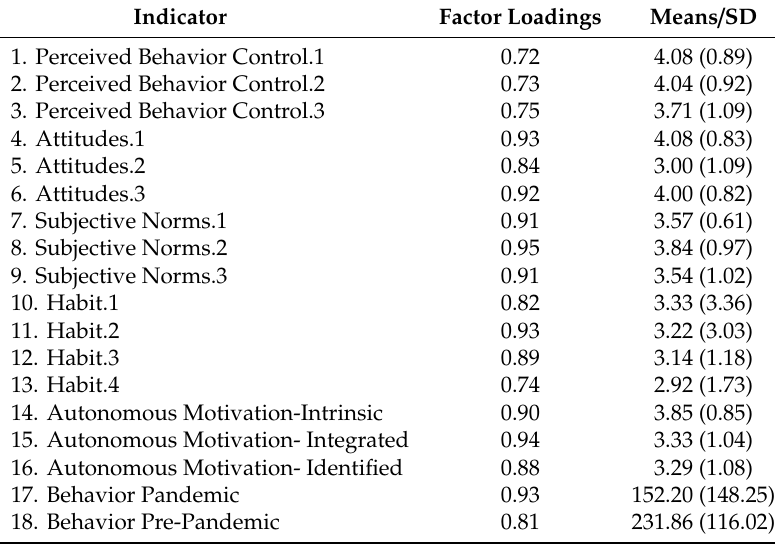
Table 4. Means, standard deviations, and factor loadings of study